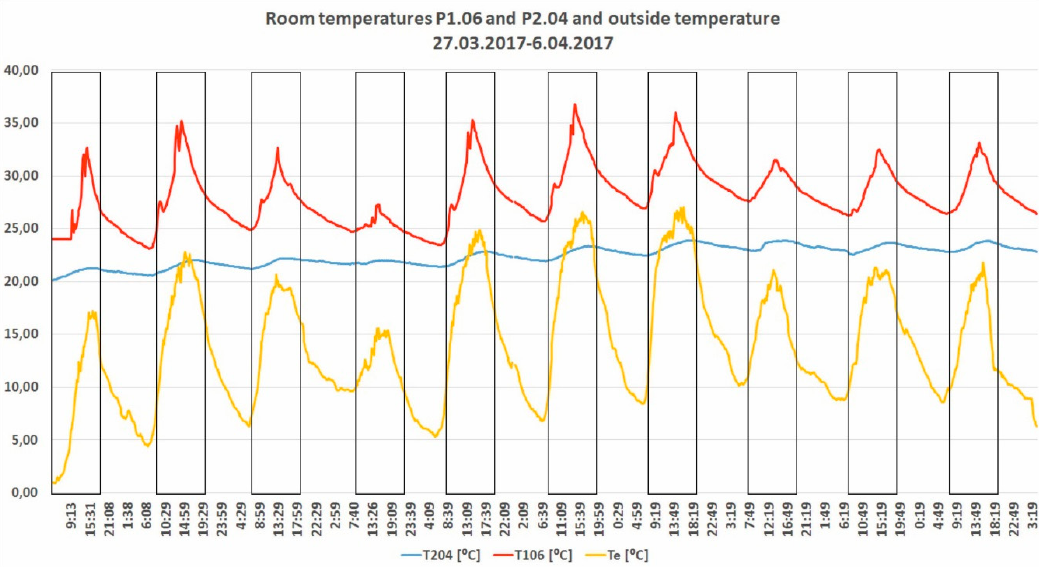
Figure 14. Wavelength of outdoor and ambient air temperatures in rooms P1.06 (with no venetian blinds) and P2.04 (with external shading devices). Visible data gaps are caused by technical problems with the measuring equipment. The sensors had to be submitted for technical inspection.